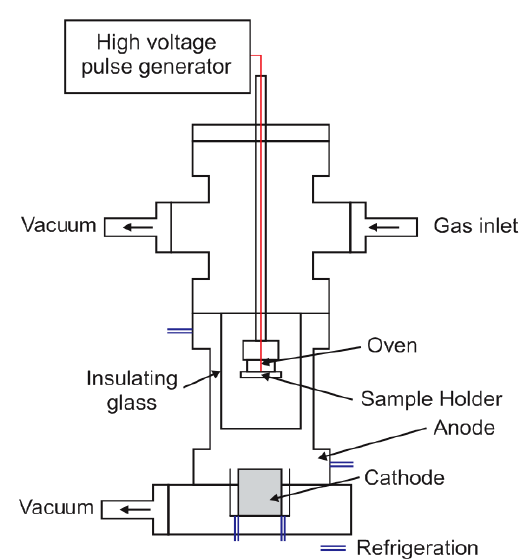
Figure 1. Scheme experimental Cathodic Arc